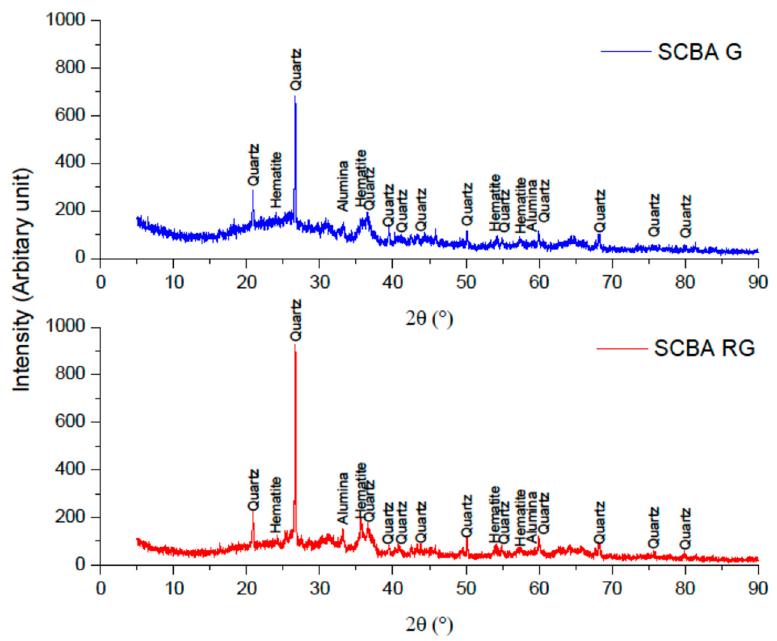
Figure 10. XRD of SCBAs. Table 4. Flow, cement setting time, dry bulk density, and water